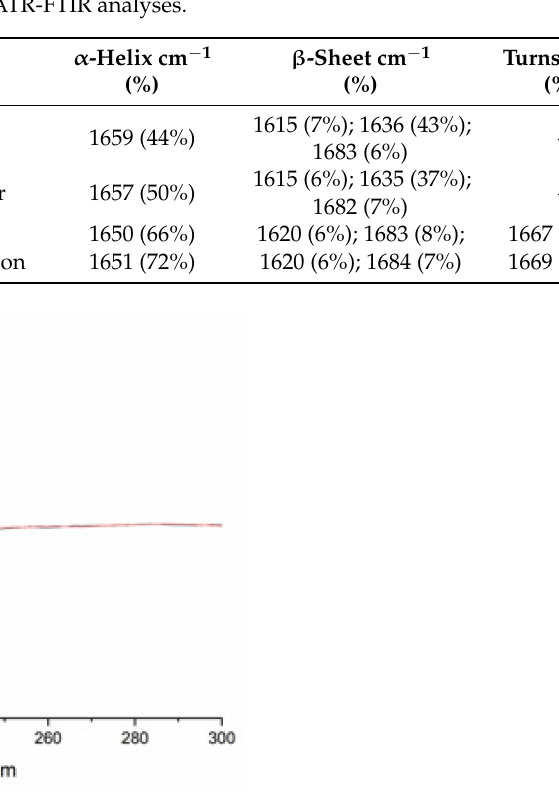
Figure 4. CD spectra of lysozyme HCl (black line) and heat-treated lysozyme HCl (red line) in water (0.25